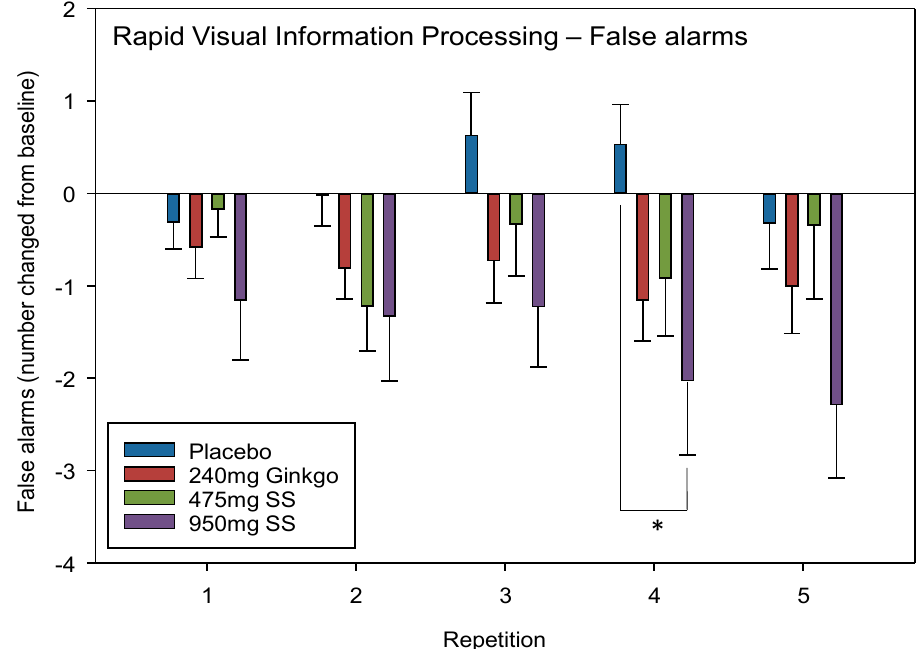
Figure 5. Rapid Visual Information Processing (RVIP) False alarms. Mean (±SEM) change ‐ from ‐ baseline false alarms on the RVIP task on Day 1 (repetition 1 = post ‐ dose repetition 1 on Day 1, repetition 2 = post ‐ dose repetition 2 on Day 1) and following 28 days of supplementation with 475 mg Sideritis scardica (SS), 950 mg SS, active control (240 mg Ginkgo biloba ) or placebo control (repetition 3 = pre ‐ dose baseline on Day 28, repetition 4 = post ‐ dose repetition 1 on Day 28 and repetition 5 = post ‐ dose repetition 2 on Day 28). * p < 0.05, ** p < 0.01 and t = trend.